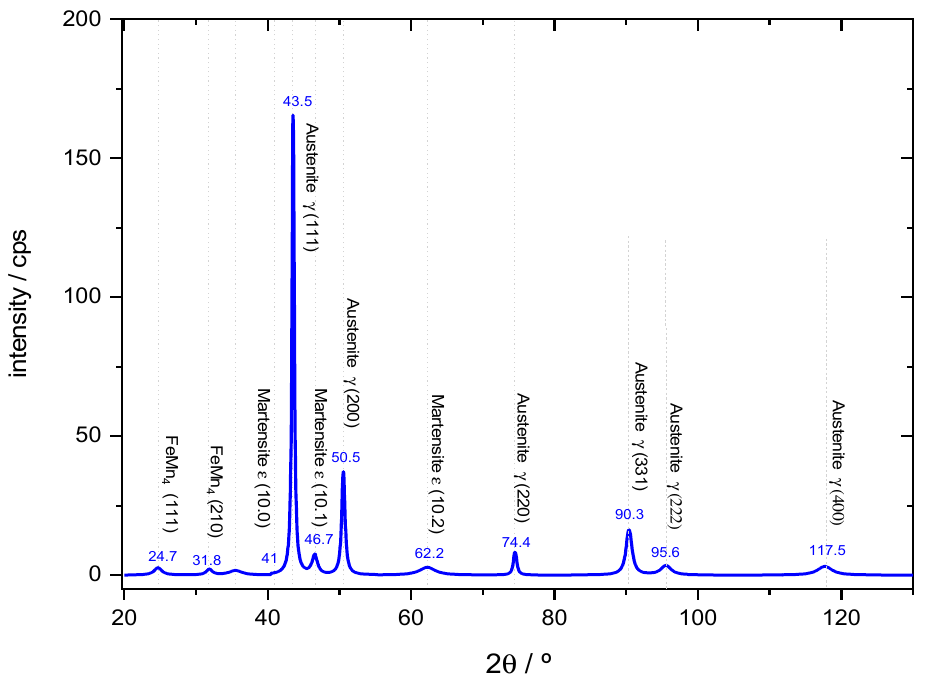
Figure 4. XRD pattern corresponding to the Fe-28Mn-6Si-5Cr SMS alloy in pre-strained state. As expected, the γ -austenite is the predominant phase with the strongest diffraction peaks at 2 θ = 43.5 ◦ and 2 θ = 50.5 ◦ , which correspond to the reflections of (111) and (200) planes, respectively. The lower intensity peaks are located at 2 θ = 74.4 ◦ , 2 θ = 90.3 ◦ , 2 θ = 95.6 ◦ , and 2 θ = 117.5 ◦ , associated with the reflection of the (220), (311), (222), and (400) planes, as labeled in Figure 4. In addition, the ε -martensite phase is also detected, confirmed by the presence of small peaks at 2 θ = 46.7 ◦ and 2 θ = 62.2 ◦ ascribed to the (10.1) and (10.2) planes, respectively [1]. On the other hand, no peaks related to the α ’-martensite (bcc) have been detected; this result is expected considering the Mn content of the studied alloy (28%wt.). Previous studies postulate that a minimum of 21% wt. Mn content is necessary to stabilize the ε -martensite in respect of the α ’-martensite phase [10]. As aforementioned, the SME in the iron-based shape memory alloys results from the stress-induced transformation of γ -austenite to ε -martensite and its reversion ( ε → γ ) by heating. To characterize this reversibility, the pre-strained alloy was heated at a temperature above A f . In these conditions, the reverse transformation should be activated. Figure 5 illustrates the changes in SMS alloy subjected to a temperature of 160 ◦ C for 5